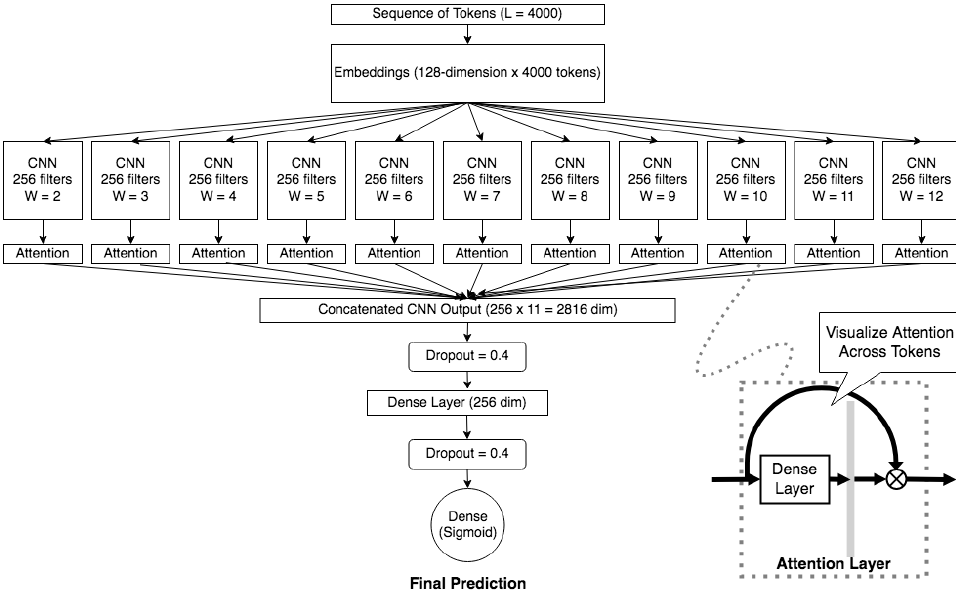
Figure 2. Schematic of CNN-Attention architecture used in this paper. The input is a sequence of L integer tokens, which is processed to a matrix of token embedding vectors with trainable embedding weights. The embeddings are fed into CNNs which vary by kernel width as shown in the diagram. The output is fed into a feed forward attention layer, which is shown in the inset at the bottom, based on the structure described in [81]. The attention at that layer will have a dimensionality equal to the sequence length minus the kernel width, allowing values across the sequence to be visualized. The outputs of the attention layer, which will have a dimensionality equal to the number of convolutional filters, are then concatenated to form an, in this case, 11 times 256 or 2816-dimensional output, which is in turn fed to a densely connected layer with a 256-dimensional output, and then a final densely connected layer with sigmoid activation function to make a binary